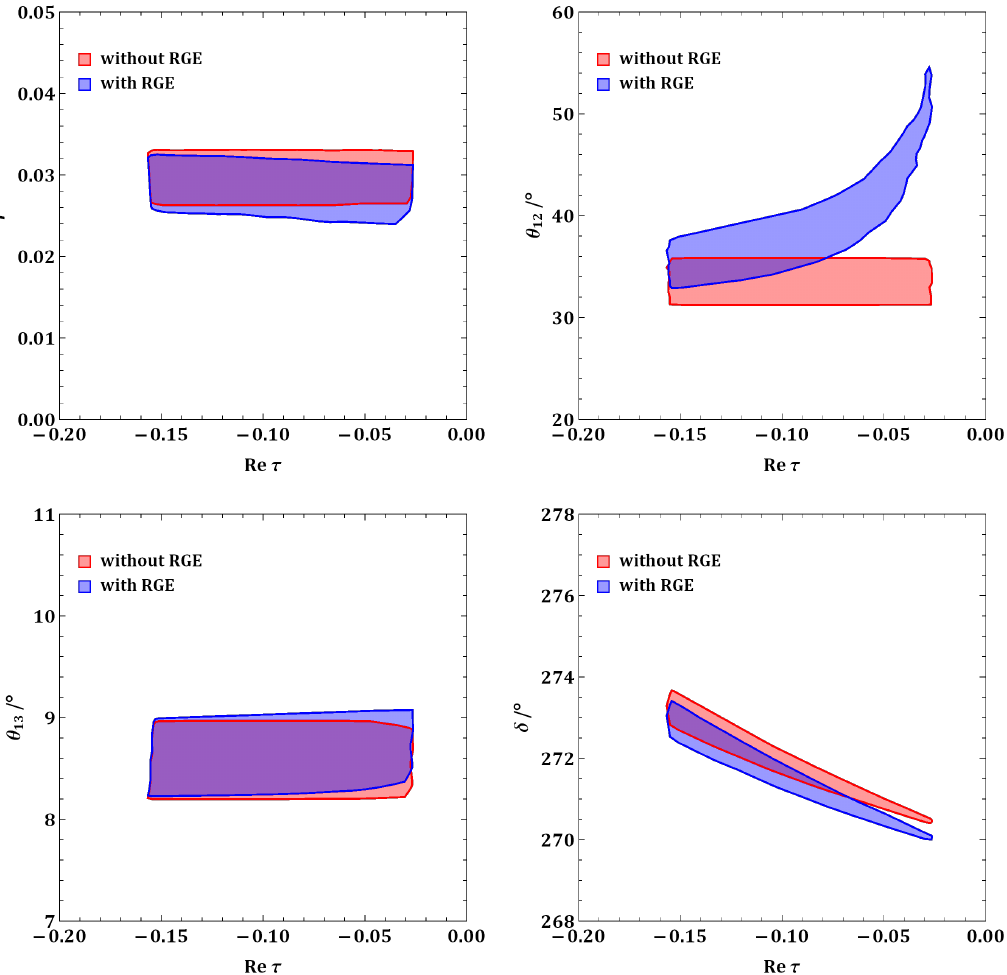
Figure 5 . Correlations between low-energy observables { r, θ Re τ , where the red-shaded areas are gained by inputting the 3 σ allowed parameter space in section 4 without the RG running effects, while the blue-shaded areas are obtained with same input but by taking account of the RG running effects from the GUT scale to the electroweak